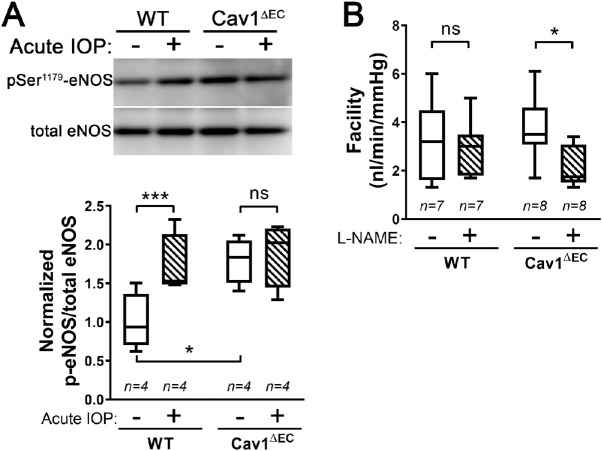
Deficiency of endothelial caveolae results in eNOS hyperactivity in the CO pathway. (A) Immunoblot depicting eNOS and phosphorylated eNOS (p-eNOS) expression in iridocorneal tissue from WT and Cav1ΔEC mice (A, top). In WT, p-eNOS expression was significantly higher in protein lysates from mice with an acute 30 mm Hg IOP elevation (n = 4) compared with mice with no IOP elevation (n = 4, P < 0.001, repeated measure two-way ANOVA, Sidak's post hoc test). As well, p-eNOS expression was significantly increased in Cav1ΔEC with no IOP elevation compared with WT with no IOP elevation (P = 0.02, repeated measure two-way ANOVA, Sidak's post hoc test) (A, bottom). In Cav1ΔEC mice, no change in p-eNOS expression was observed between acute IOP elevation (n = 4) and no IOP elevation (n = 4) (repeated measure two-way ANOVA, Sidak's post hoc test). (B) Outflow facility was measured in perfused, enucleated eyes subjected to sequential pressure steps. L-NAME treatment had no effect on conventional, pressure-dependent outflow in WT eyes (n = 7) compared with no drug treatment (n = 7). Contrastingly, outflow facility was significantly reduced in Cav1ΔEC eyes treated with L-NAME (n = 8) compared with no drug treatment (n = 8) (*P < 0.05, n = 7–8, ratio paired t test).